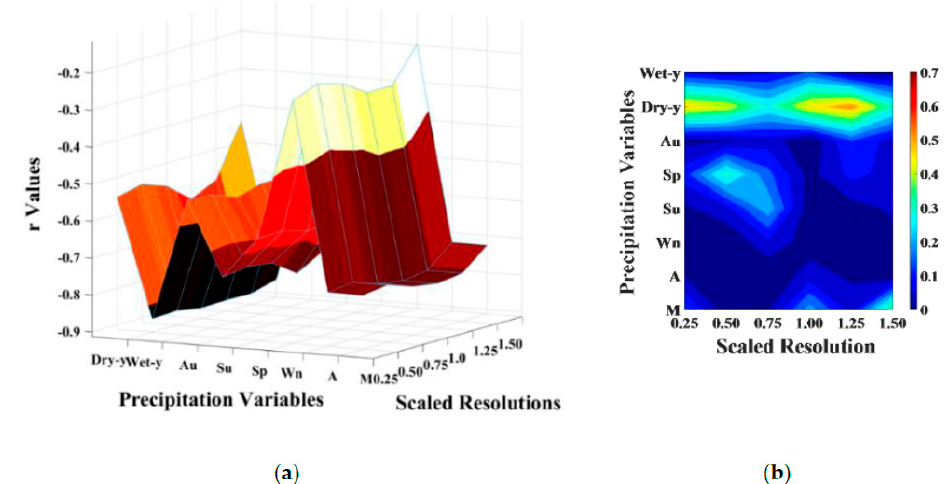
Figure 3. Selection of initial input parameters for EDBF) algorithm to predict the weighted precipitation ( a ) calculated r values, and ( b ) the correlation between precipitation variables and the low-resolution scales for assigned weight values.